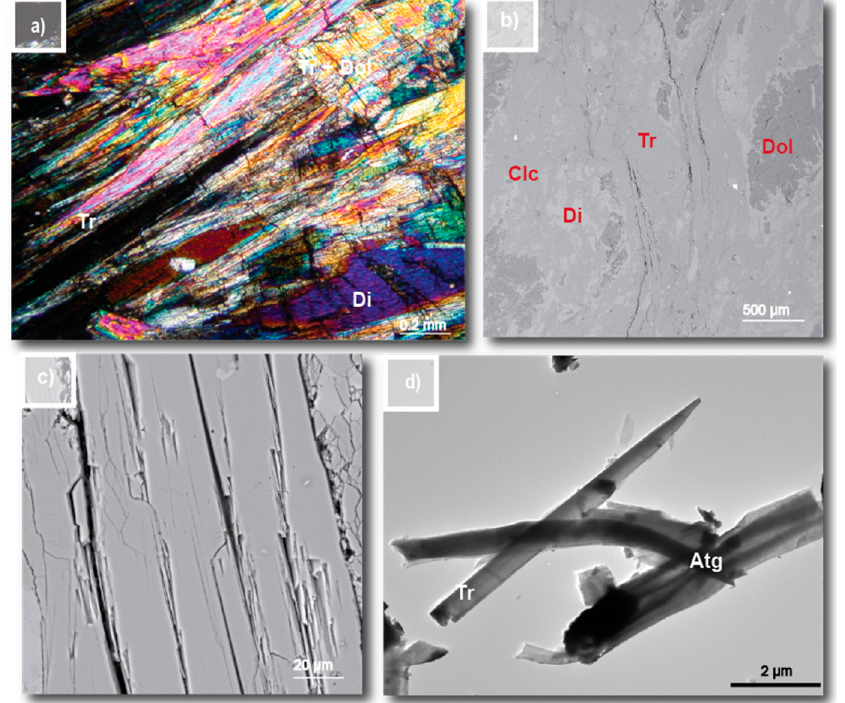
Figure 4. Sample 2 (S2). ( a ) Photomicrograph of the tremolite vein in the serpentinite; crossed polars. ( b ) SEM image (100× magnification) of the vein of the serpentinite. ( c ) SEM image detail (2000× magnification) of the acicular/fibrous tremolite (HV: 20 kV; Det: BSE). ( d ) TEM image of tremolite + fibrous antigorite. Mineral name abbreviations are according to [36]. Atg: antigorite; Clc: clinochlore; Di: diopside; Do: dolomite; Tr: tremolite.